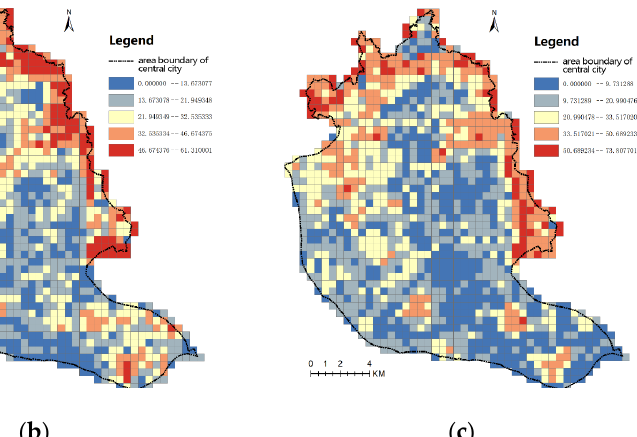
Figure 7. LSI change in the central area of Fuzhou City: ( a ) landscape shape index of 2000; ( b ) landscape shape index of 2010; ( c ) landscape shape index 2021. Red is the high LSI value; blue is the low LSI value.